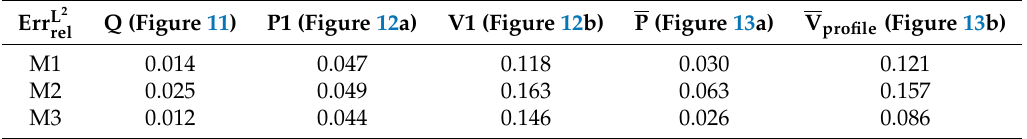
Table 4. L 2 error norms of the flow quantities shown in Figures 11–13 for the meshes M1-M3 relative to the base